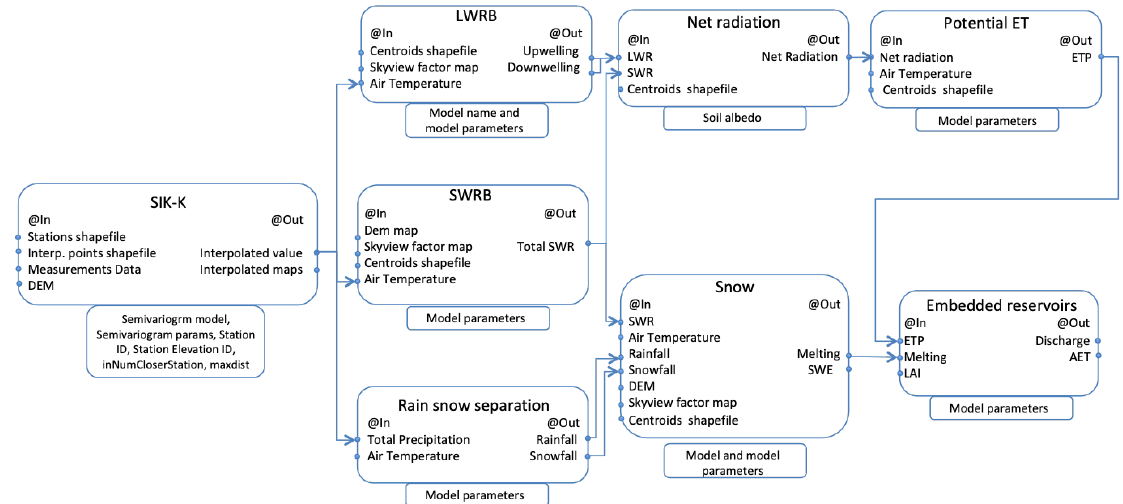
Figure 4. The modeling solution adopted in this work allows for the simulation of the entire hydrological budget: from the spatialization of the temperature data (SIK-K component [26]) to the runoff production (Embedded reservoirs